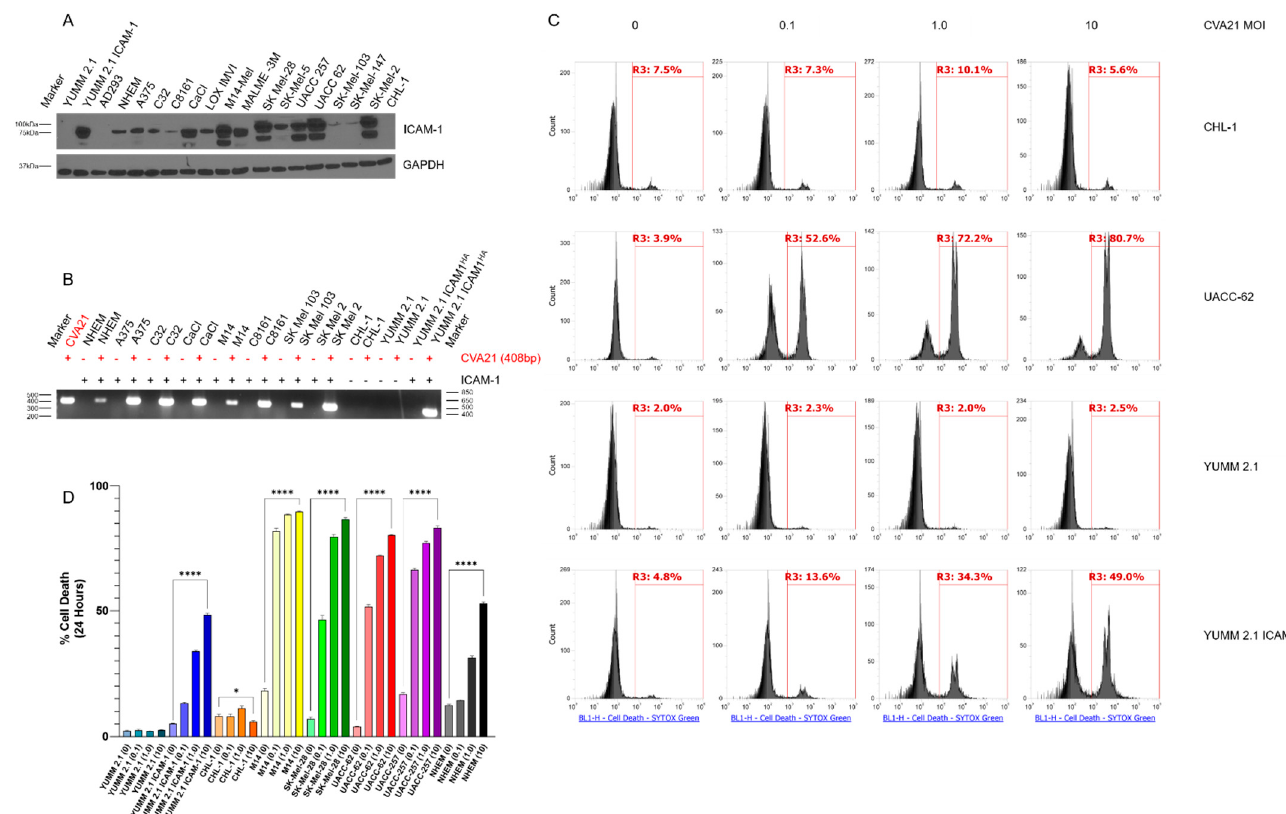
Figure 1. Melanoma cells are susceptible to CVA21 infection and cell death. ( A ) Immunoblot of a panel of melanoma cell lines probing for ICAM-1. GAPDH was used as a loading control. Mouse YUMM 2.1 cells and lentivirally transduced YUMM 2.1 ICAM-1 cells were used as negative and positive controls for ICAM-1, respectively. ( B ) RT-PCR of RNA extracted from a panel of melanoma cell lines infected with CVA21 compared to uninfected parental lines. RT-PCR on purified CVA21 stock was used as a positive control for comparison. The RT-PCR produces an amplicon from the 3 ′ end of the viral genome in the 3D pol . ( C ) Assessment of cell death following CVA21 infection at MOI 0, 0.1, 1.0, and 10 at 24 h by flow cytometry in representative cell lines. SYTOX Green was used to stain dead cells. ( D ) Quantitation of cell death from the flow cytometry assay represented in panel ( C ). Samples were run in triplicate and analyzed using a one-way ANOVA test for statistical differences. Error bars represent the standard deviation between replicates. p values < 0.05 were considered significant ( p < 0.05 *, < 0.0001 ****).